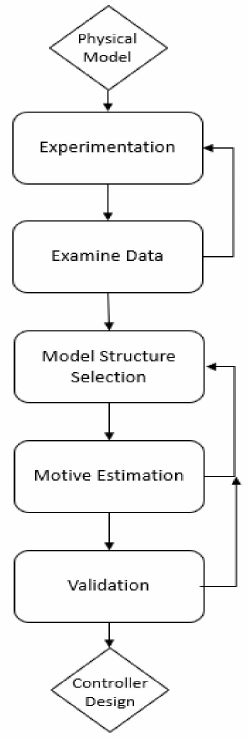
Figure 9. System